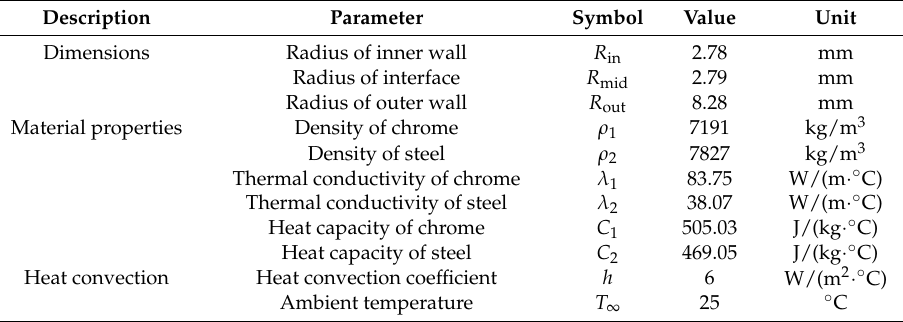
Table 1. Parameters used for numerical simulation.